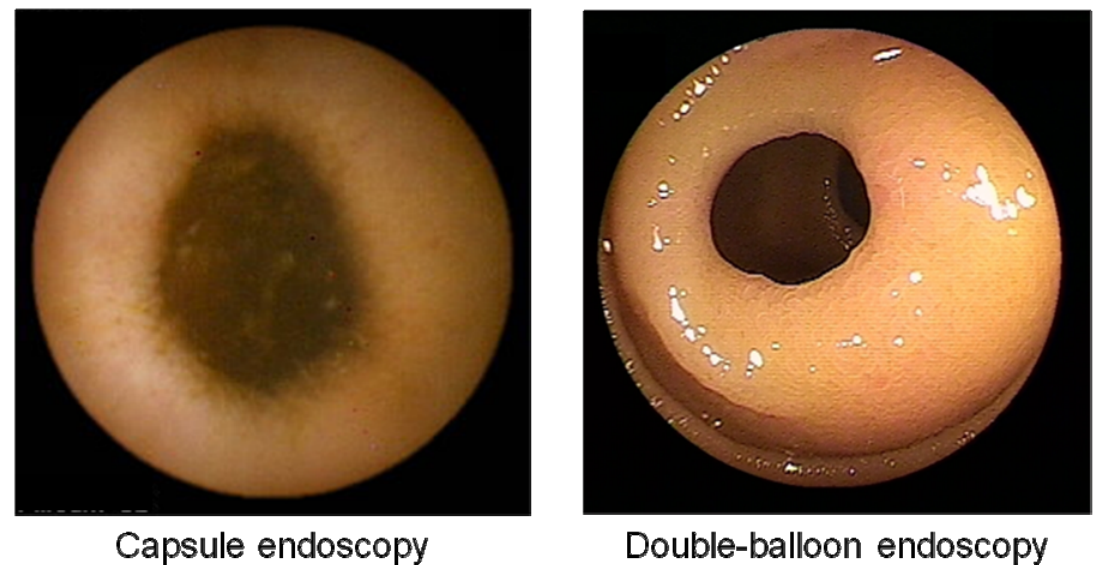
Figure 3. Traditional NSAIDs-induced diaphragm-like